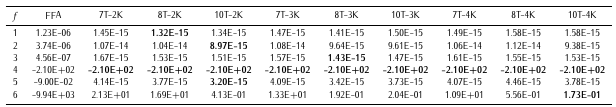
Table 3. Results: 10 fireflies and Crossover with Simulated Annealing with the K best threads